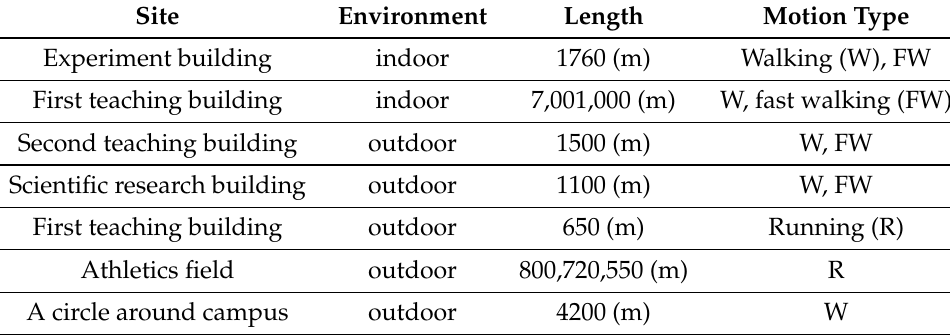
Table 1. Details of routes and motion